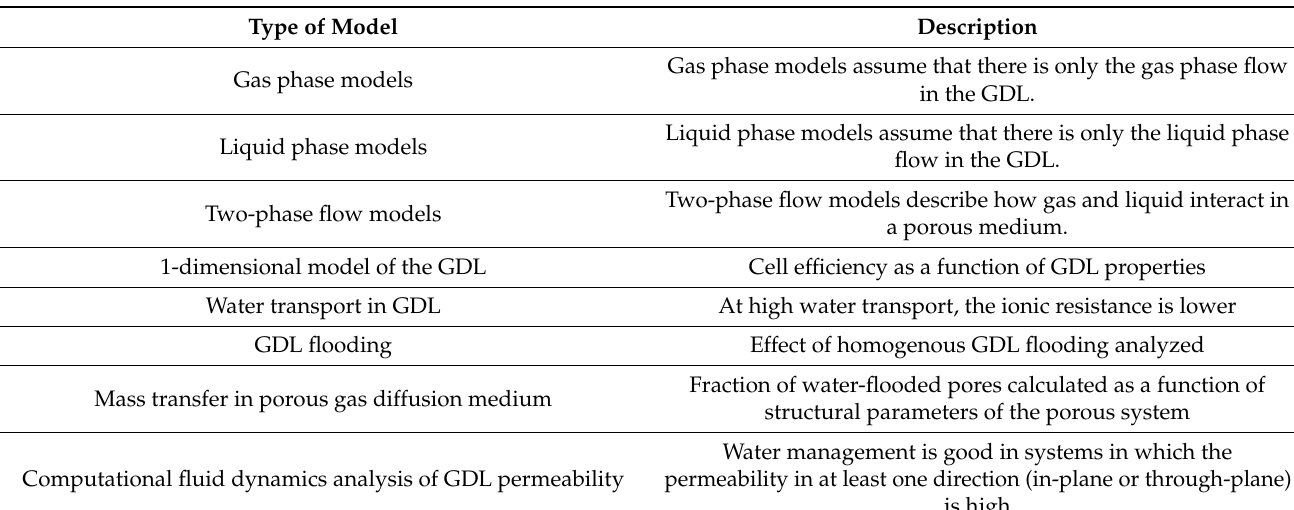
Table 2. Types of Gas Diffusion Layer models investigated in the